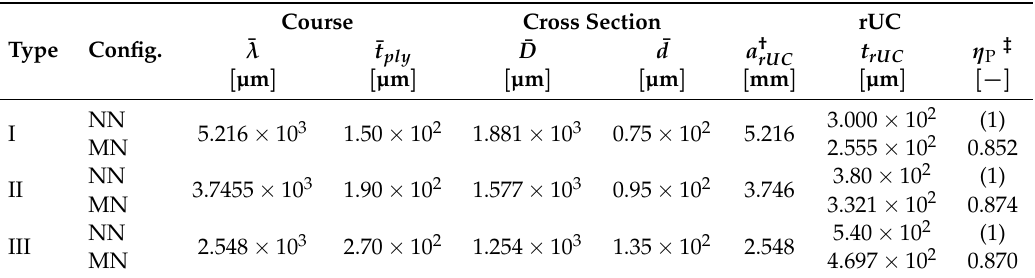
Table 5. Geometry parameters of yarn course and cross section and consequentially of the rUCs in NN and MN configuration of each type.